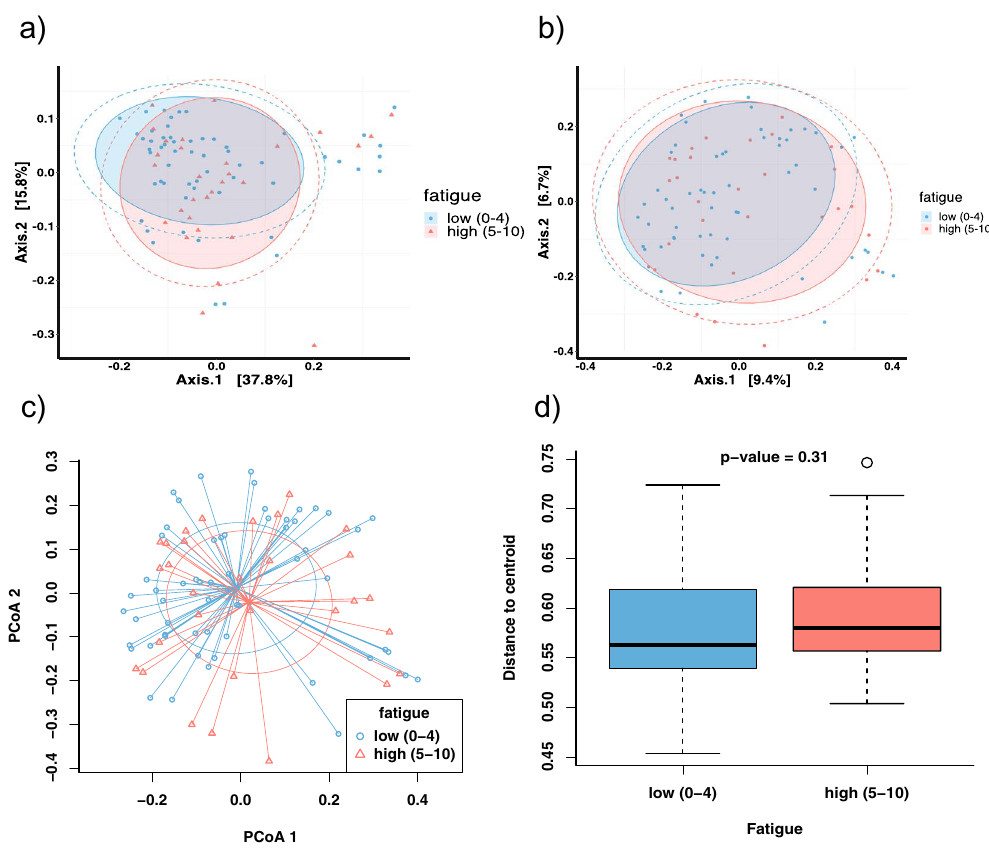
Figure 2. Results of the principal coordinate analysis (PCoA) showing differences in beta diversity between low-and high-fatigue patients. ( a ) PCoA plots using weighted-UniFrac metric. The x-axis explains 37.8% variation of the data. The y-axis explains 15.8% variation of the data. Each blue dot represents the PCoA score of one patient in the low-fatigue group; Each red triangle represents the PCoA score of one patient in the high- fatigue group. ( b ) PCoA plots using Bray–Curtis metric. The x-axis explains 9.4% variation of the data. The y-axis explains 6.7% variation of the data. The shaded ellipse denote the 80% confidence region of all the points. The dashed ellipse denote the 90% confidence region of all the points. ( c ) PCoA plot with individual distances to the centroid shows the inter-individual variations. Each blue dot represents the PCoA score of one patient in the low-fatigue group; Each red triangle represents the PCoA score of one patient in the high-fatigue group. ( d ) Boxplot of individual-centroid distances. The p-value is given by Tukey test. The box with blue color describes the distance distribution in the low fatigue group; The box with red color describes the distance distribution in the high fatigue group. ( c , d ) showed results from Bray–Curtis